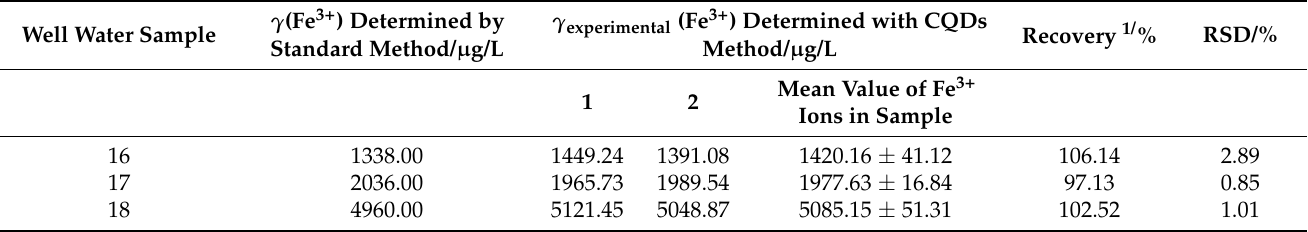
Table 4. Detection of Fe 3+ in real well water samples [80].